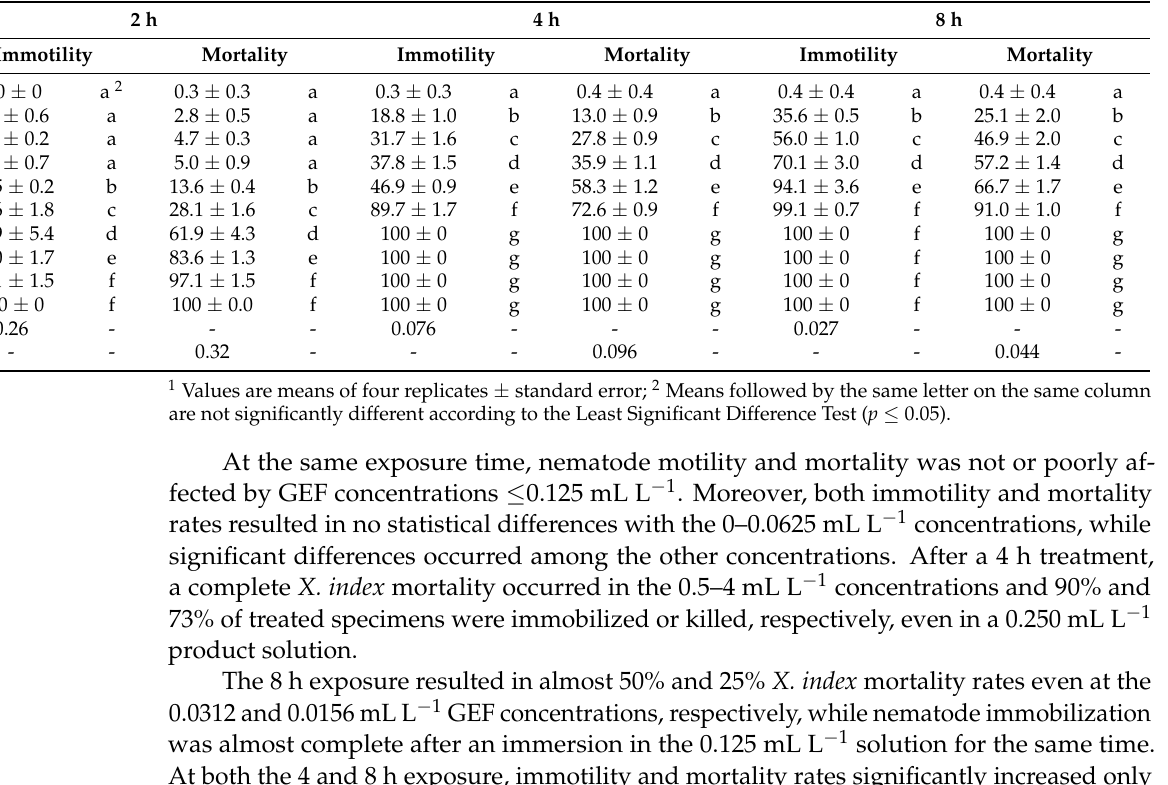
Table 1. Effect of 2-, 4- and 8-h in vitro exposure to a 0–4 mL L − 1 range of concentrations of a garlic extract formulate on motility and mortality of mixed–age specimens of Xiphinema index 1